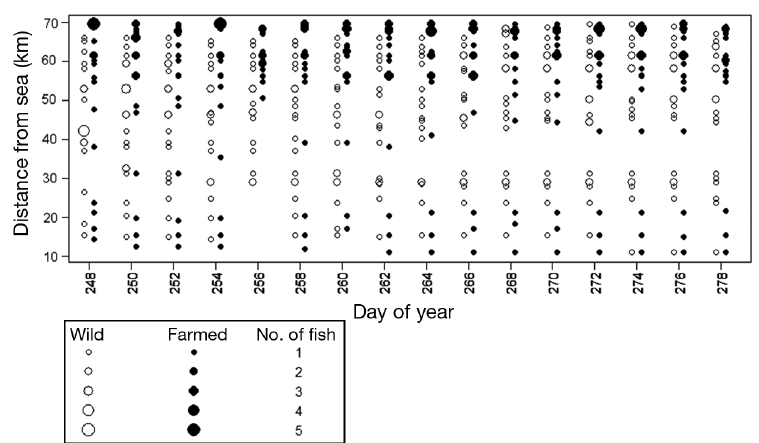
Fig. 2. Location (distance from the river mouth) of farmed and wild Atlantic salmon Salmo salar on day of the year 248 to 278 (4 September to 4 October 2012). On Day 256 (12 September), the lower 28 km were not manually tracked. For clarity in the figure, minor temporal